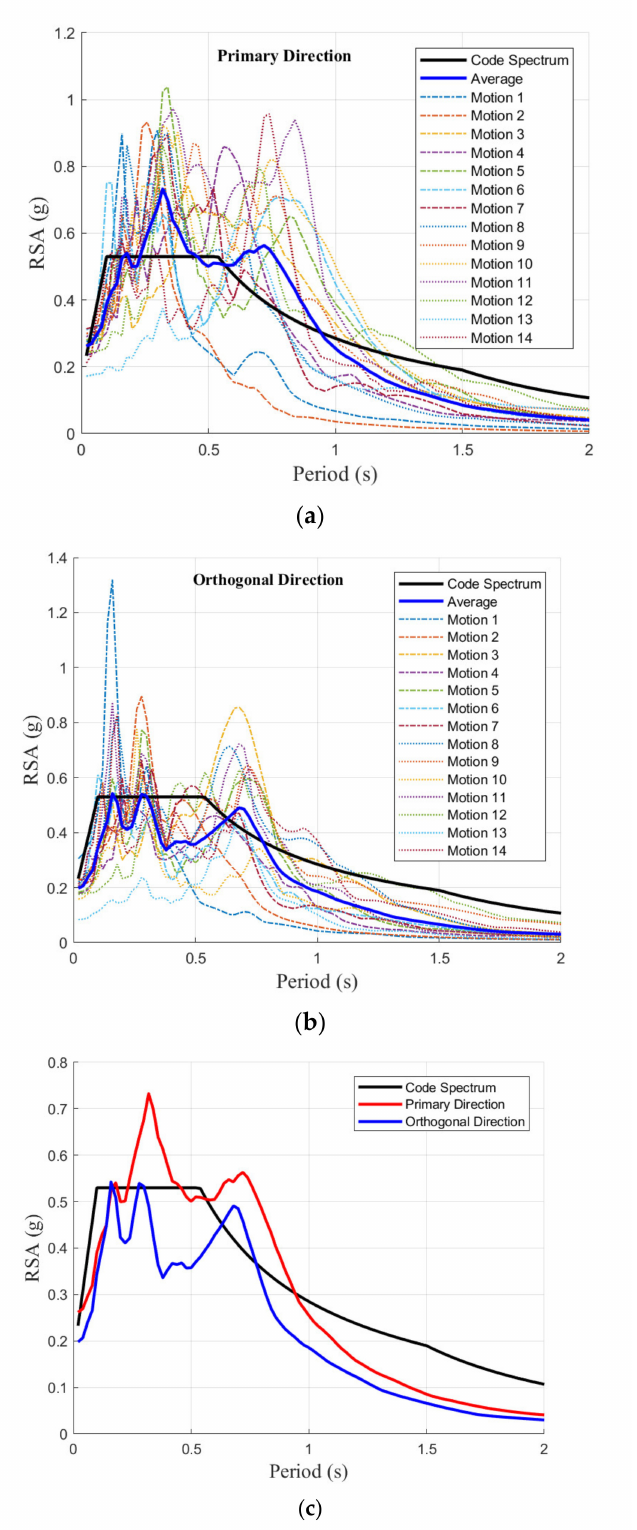
Figure 7. Case Study Output—soil surface ground motion ensemble: ( a ) site-specific acceleration response spectra in the primary direction; ( b ) site-specific acceleration response spectra in the orthogonal direction; ( c ) comparison of the mean response spectra of the primary and orthogonal directions with the class D e code